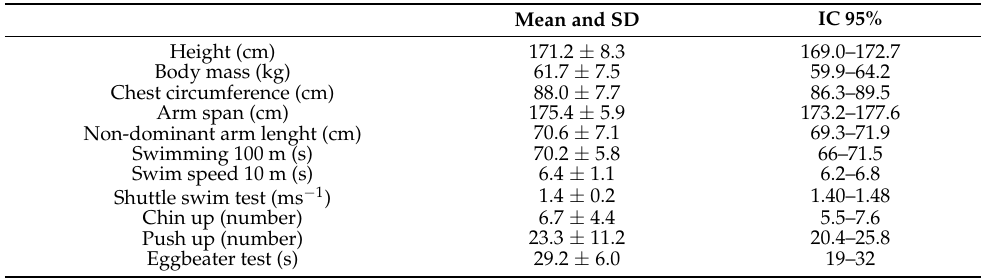
Table 2. Anthropometric and performance test for all players.